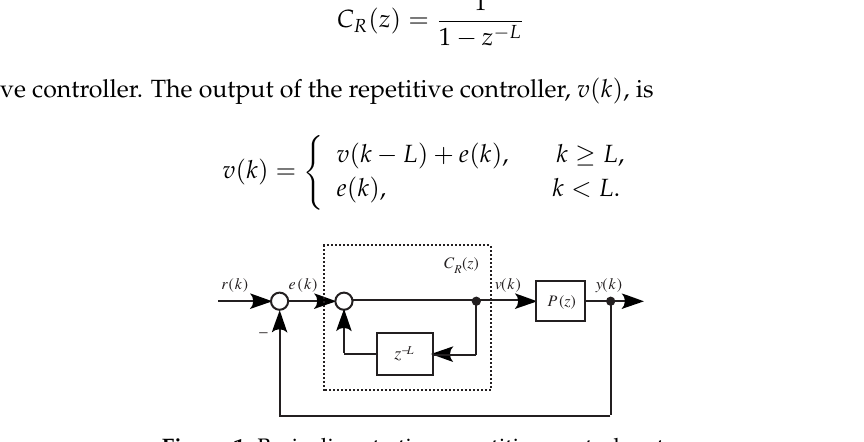
Figure 1. Basic discrete-time repetitive-control system.